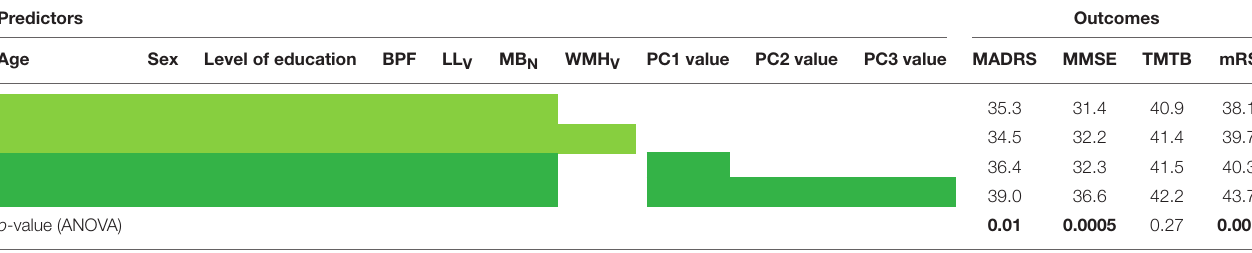
TABLE 2 | Predictive abilities of the different clinical models evaluated by their coefficients of determination.